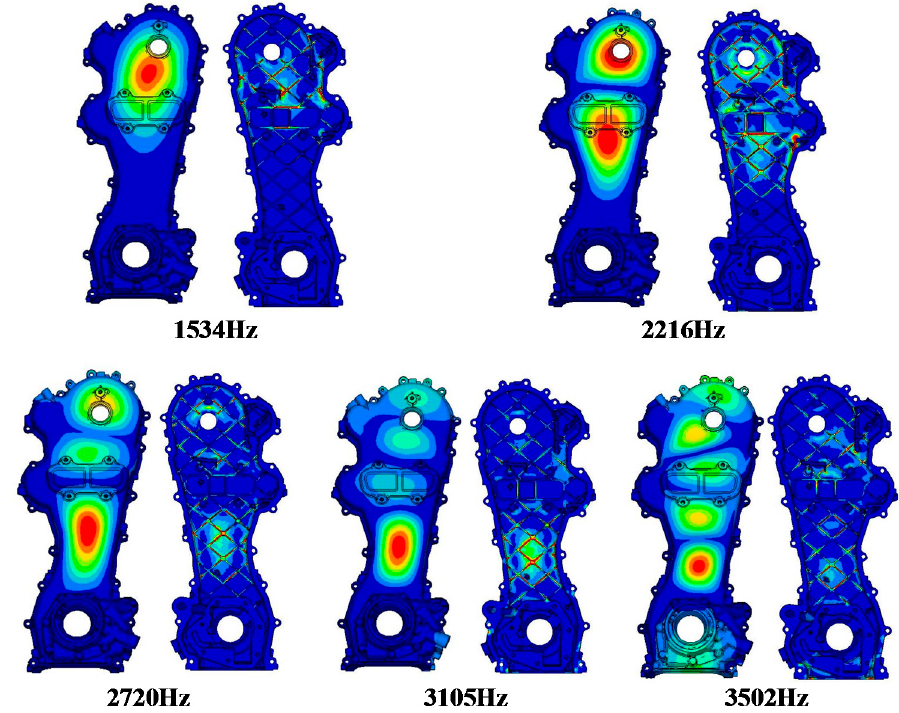
Figure 10. Chain cover eigenmodes.